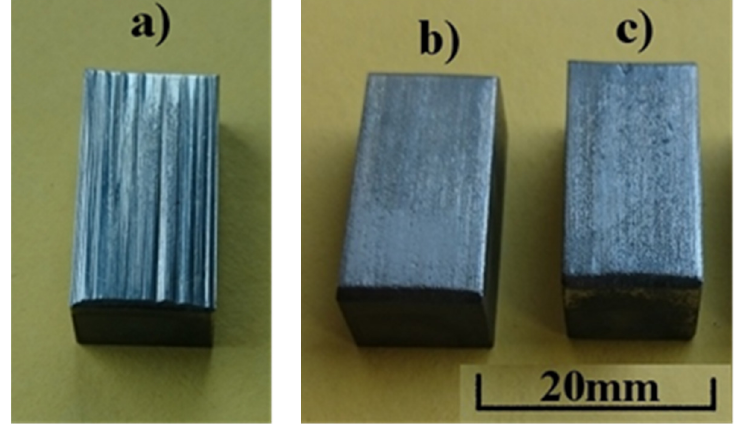
Figure 14. Surface of samples after abrasion test: ( a ) reference sample of Hadfield cast steel, ( b ) high-manganese cast steel with the addition of 3.5% Nb, ( c ) high-manganese cast steel with the addition of 4.5% Nb.